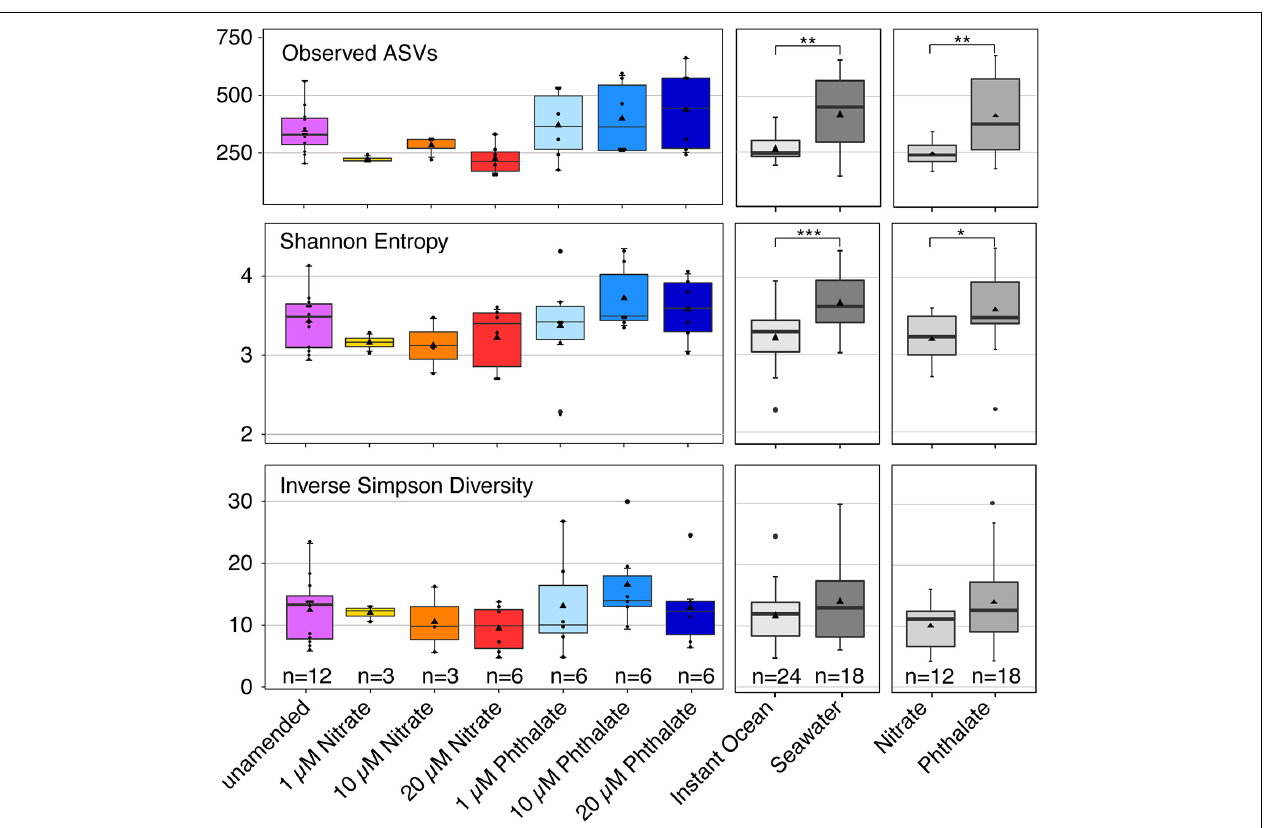
FIGURE 6 | Alpha diversity indices of different groupings of samples. Richness is shown as the number of observed bacterial amplicon sequence variants (ASV). Evenness is represented by the Inverse Simpson Diversity, Shannon entropy takes into account both richness and evenness. The number (n) of included samples per group is